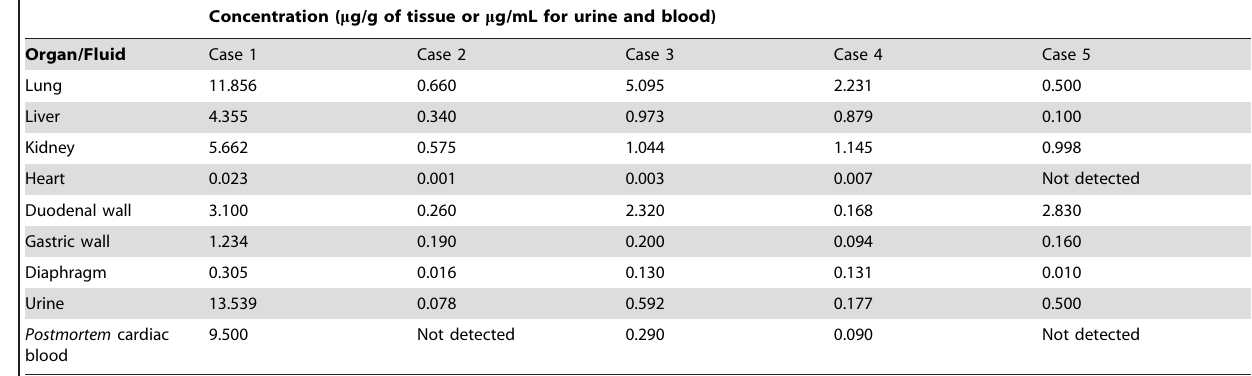
Table 2. Paraquat concentration in organs ( m g/g of tissue), urine and blood ( m g/mL) collected postmortem .